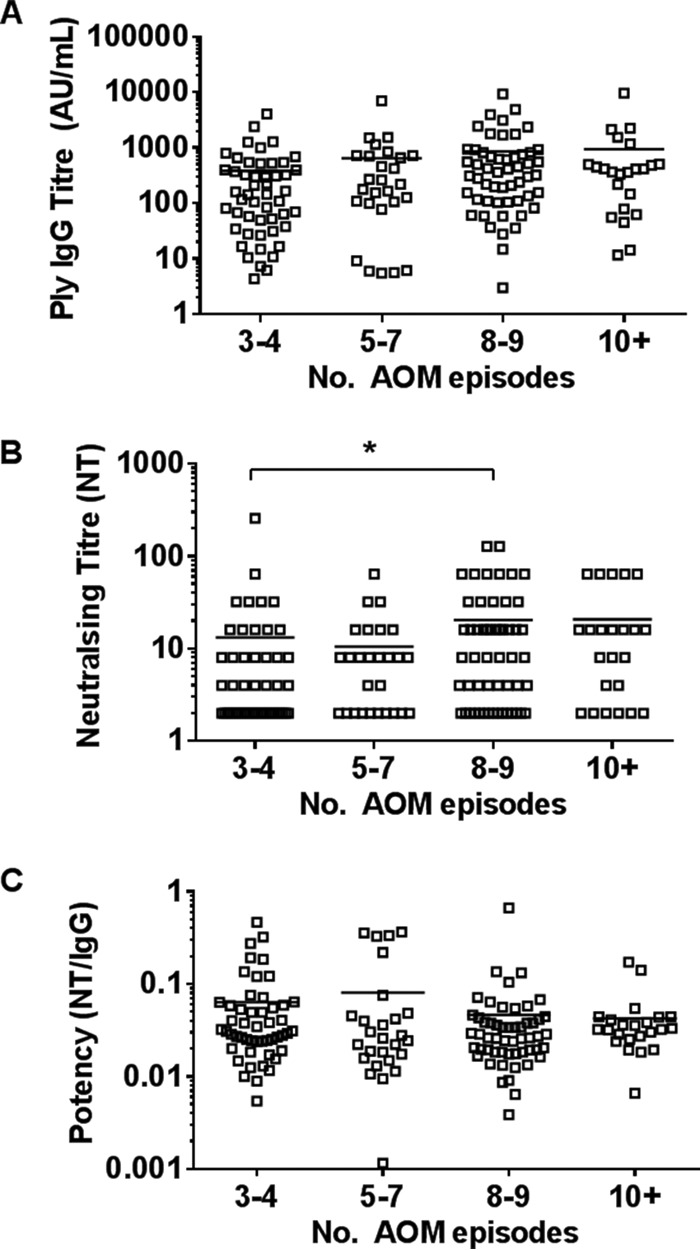
Pneumolysin IgG antibody titers (A), neutralizing titers (B), and antibody potencies (C) in sera from otitis-prone children according to the number of AOM episodes experienced. Data are presented for each individual child, with the horizontal bars depicting the means. Statistical analysis was conducted on the geometric mean of log-transformed data, correcting for age, gender, and day care attendance. *, P < 0.05.